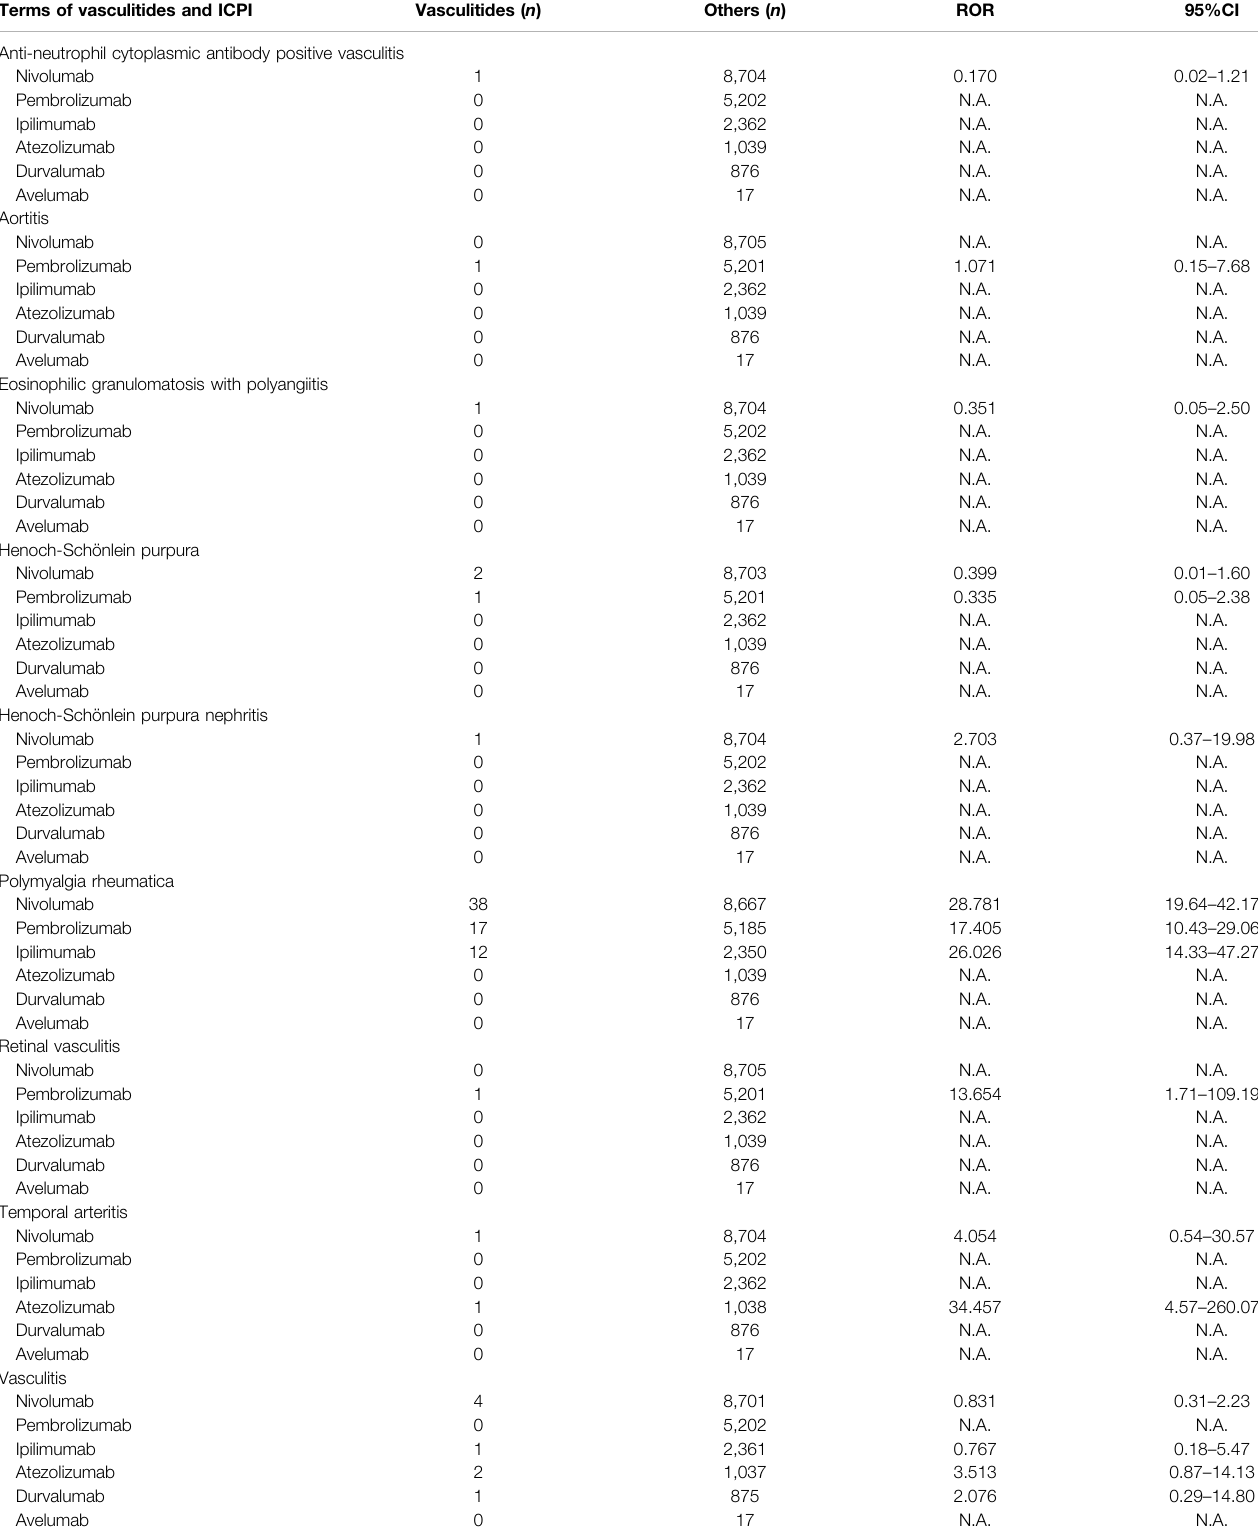
TABLE 6 | Reporting odds ratios for the types of vasculitides. Terms of vasculitides and